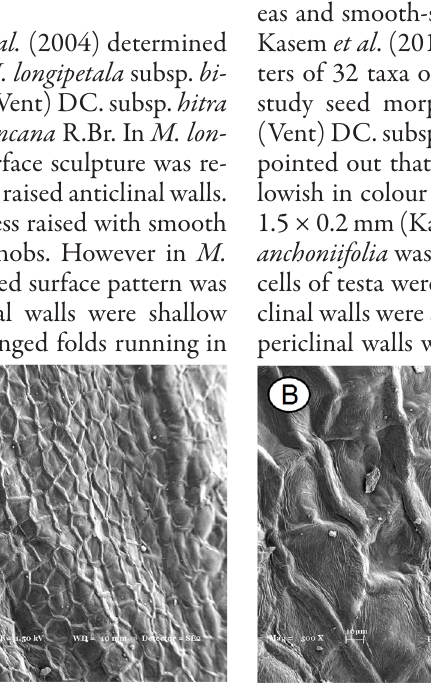
Fig. 3. Seed coat surface of M. anchoniifolia : a General view (Mag. 150x); b Testa surface (Mag.